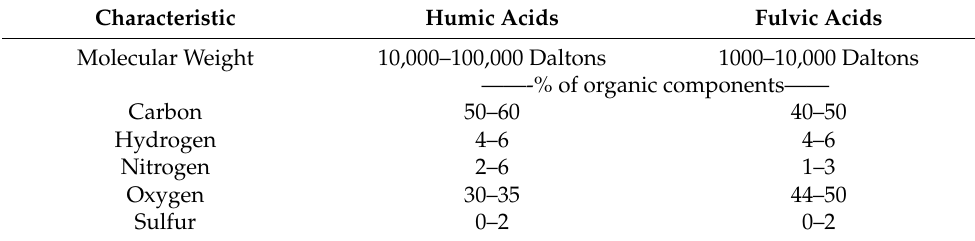
Table 2. Chemical composition of humic and fulvic acids as summarized from the literature.